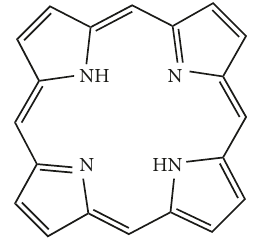
Figure 1: Structure of